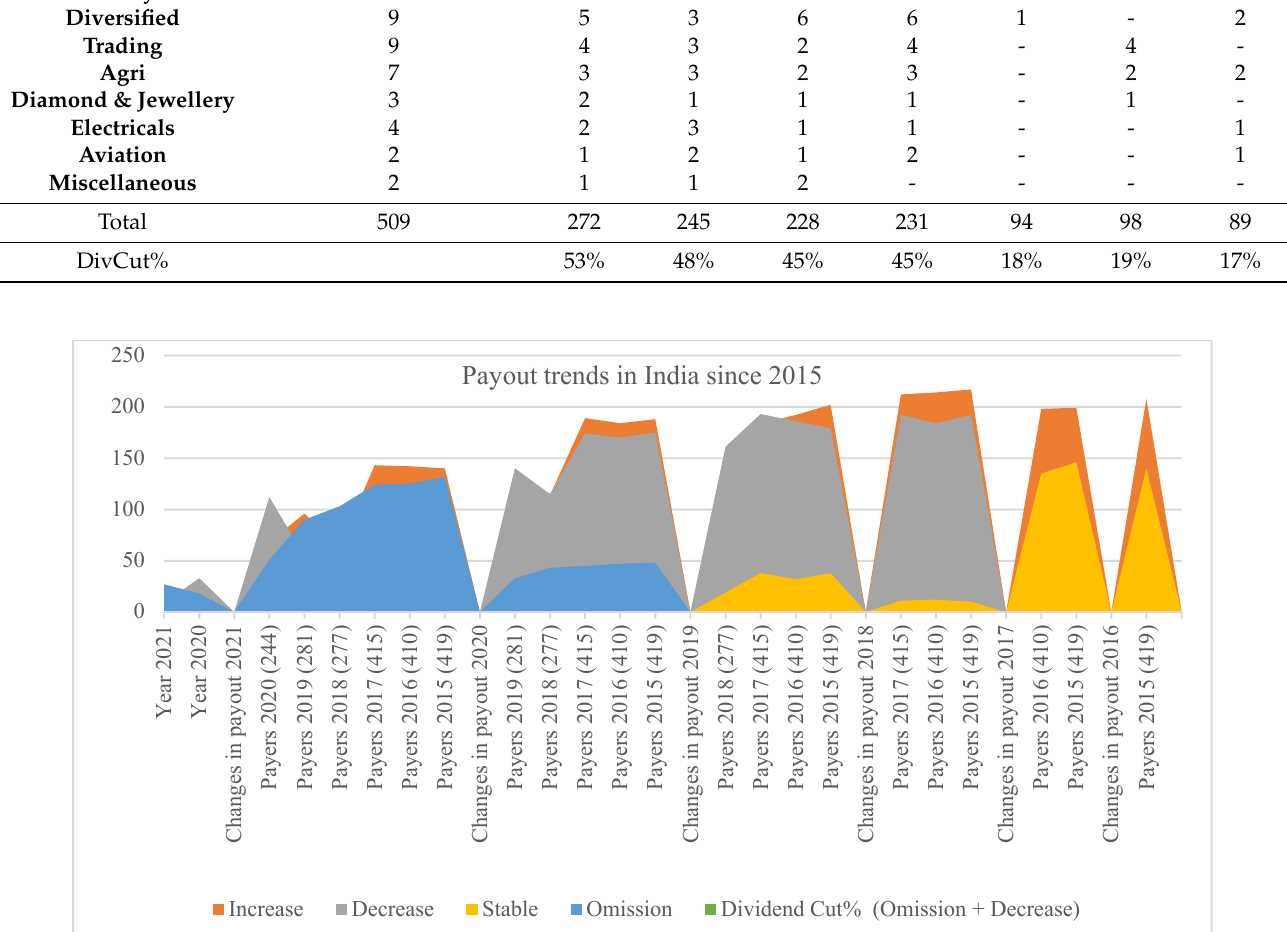
Figure 2. Changing pattern of Indian corporate payout since 2015. Table 4. Pattern of dividend cuts 2015 onwards.